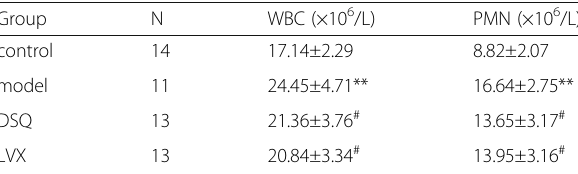
Table 4 WBC and PMN populations in bronchoalveolar lavage fluid in each group (mean ± SD)